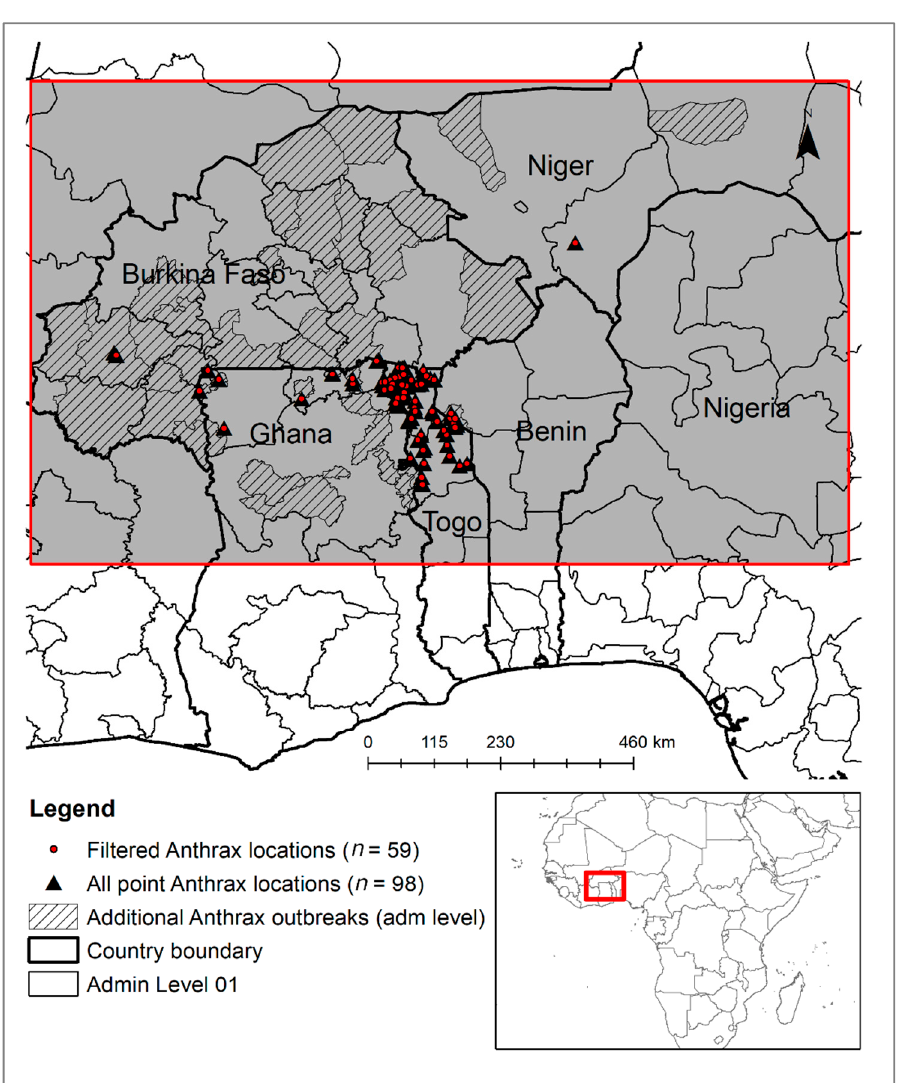
Figure 1. Study area and anthrax outbreak locations before (black triangle) and after (red dots) filtering spatial auto-correlated records (point location data source: EMPRES-i, GIMD and FAO workshop). The dashed polygons are anthrax-affected districts (adm02 level) for which geo-locations of outbreaks are missing (polygon data source: OIE-WHAIS).